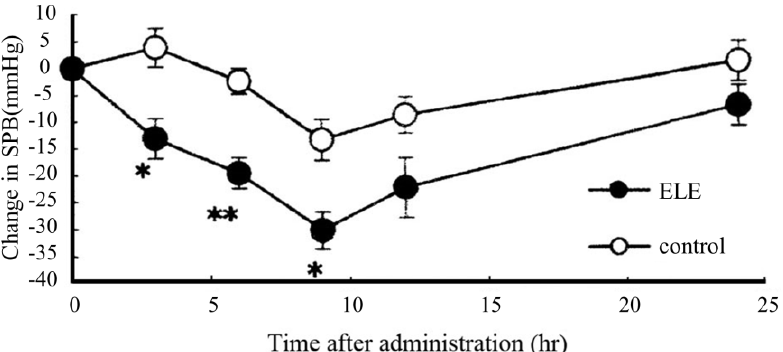
Figure 3. Effects of a single oral administration of ELE in SHR. Change in SPB is expressed as the difference in systolic blood pressure (SPB) before and after administration. ● : ELE (2000 mg/kg); ○ : saline as the control. Each value represents the mean ± standard error (S.E.) ( n = 5 – 6), n per group: ELE = 5 and control = 6. * p < 0.05 and ** p < 0.01 (Student t- test).